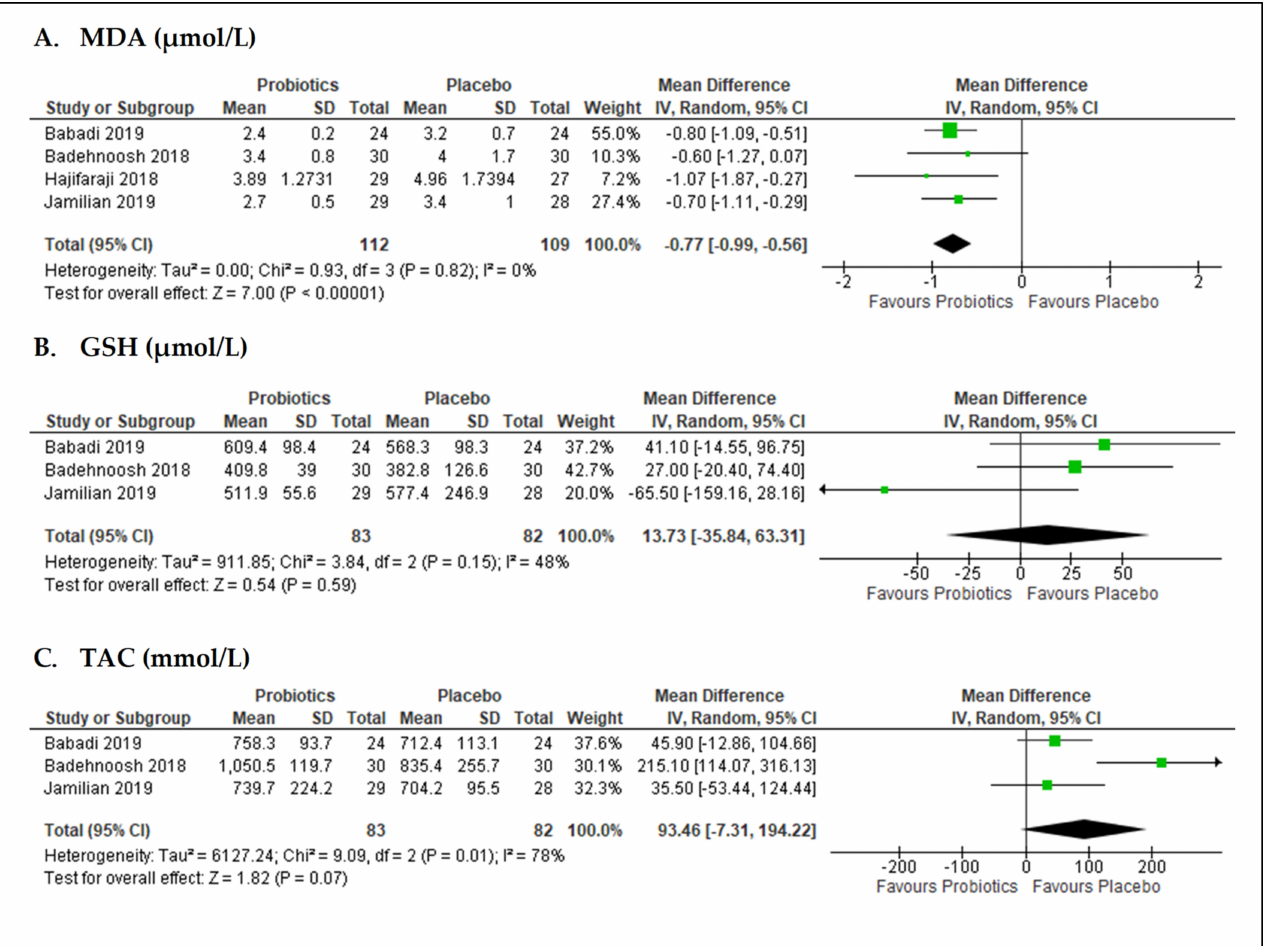
Figure 5. Forest plots for the meta-analysis of oxidative stress markers: ( A ) MDA, malondialdehyde; ( B ) GSH, glutathione; and ( C ) TAC, total antioxidant